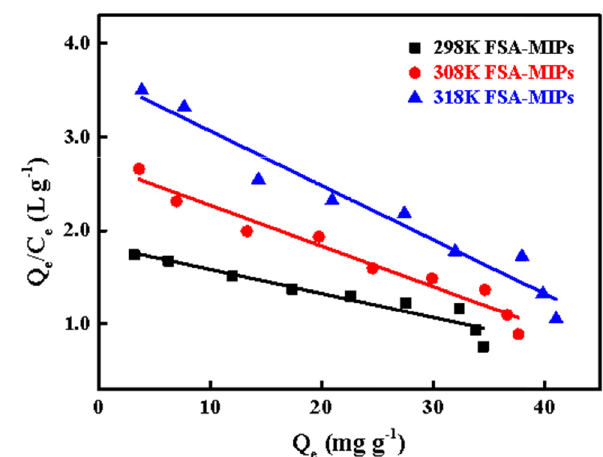
Figure A4: E ff ect of pH on the adsorption capacity of the FSA - MIPs and FSA - NIPs to 4 - MMC.